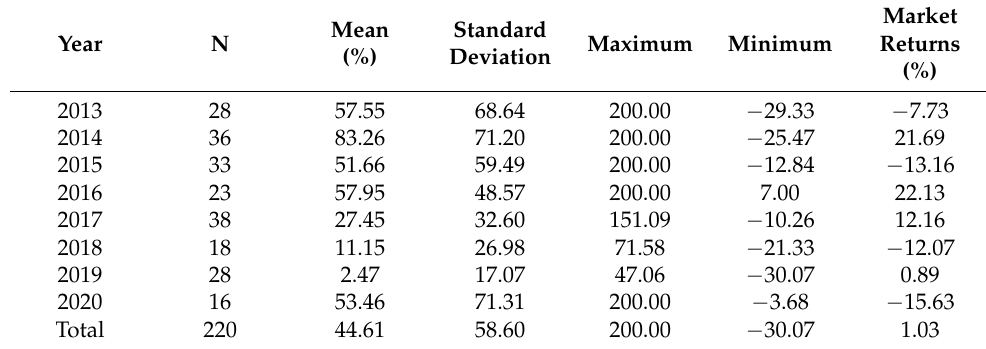
Table 2. Descriptive statistics of initial returns and market returns by year of issuance from 2013 to 2020.